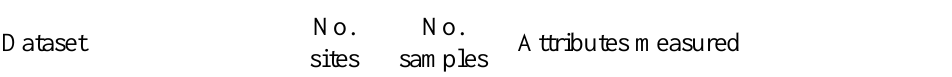
Table 1. Datasets and associated parameters; mean and range (min –